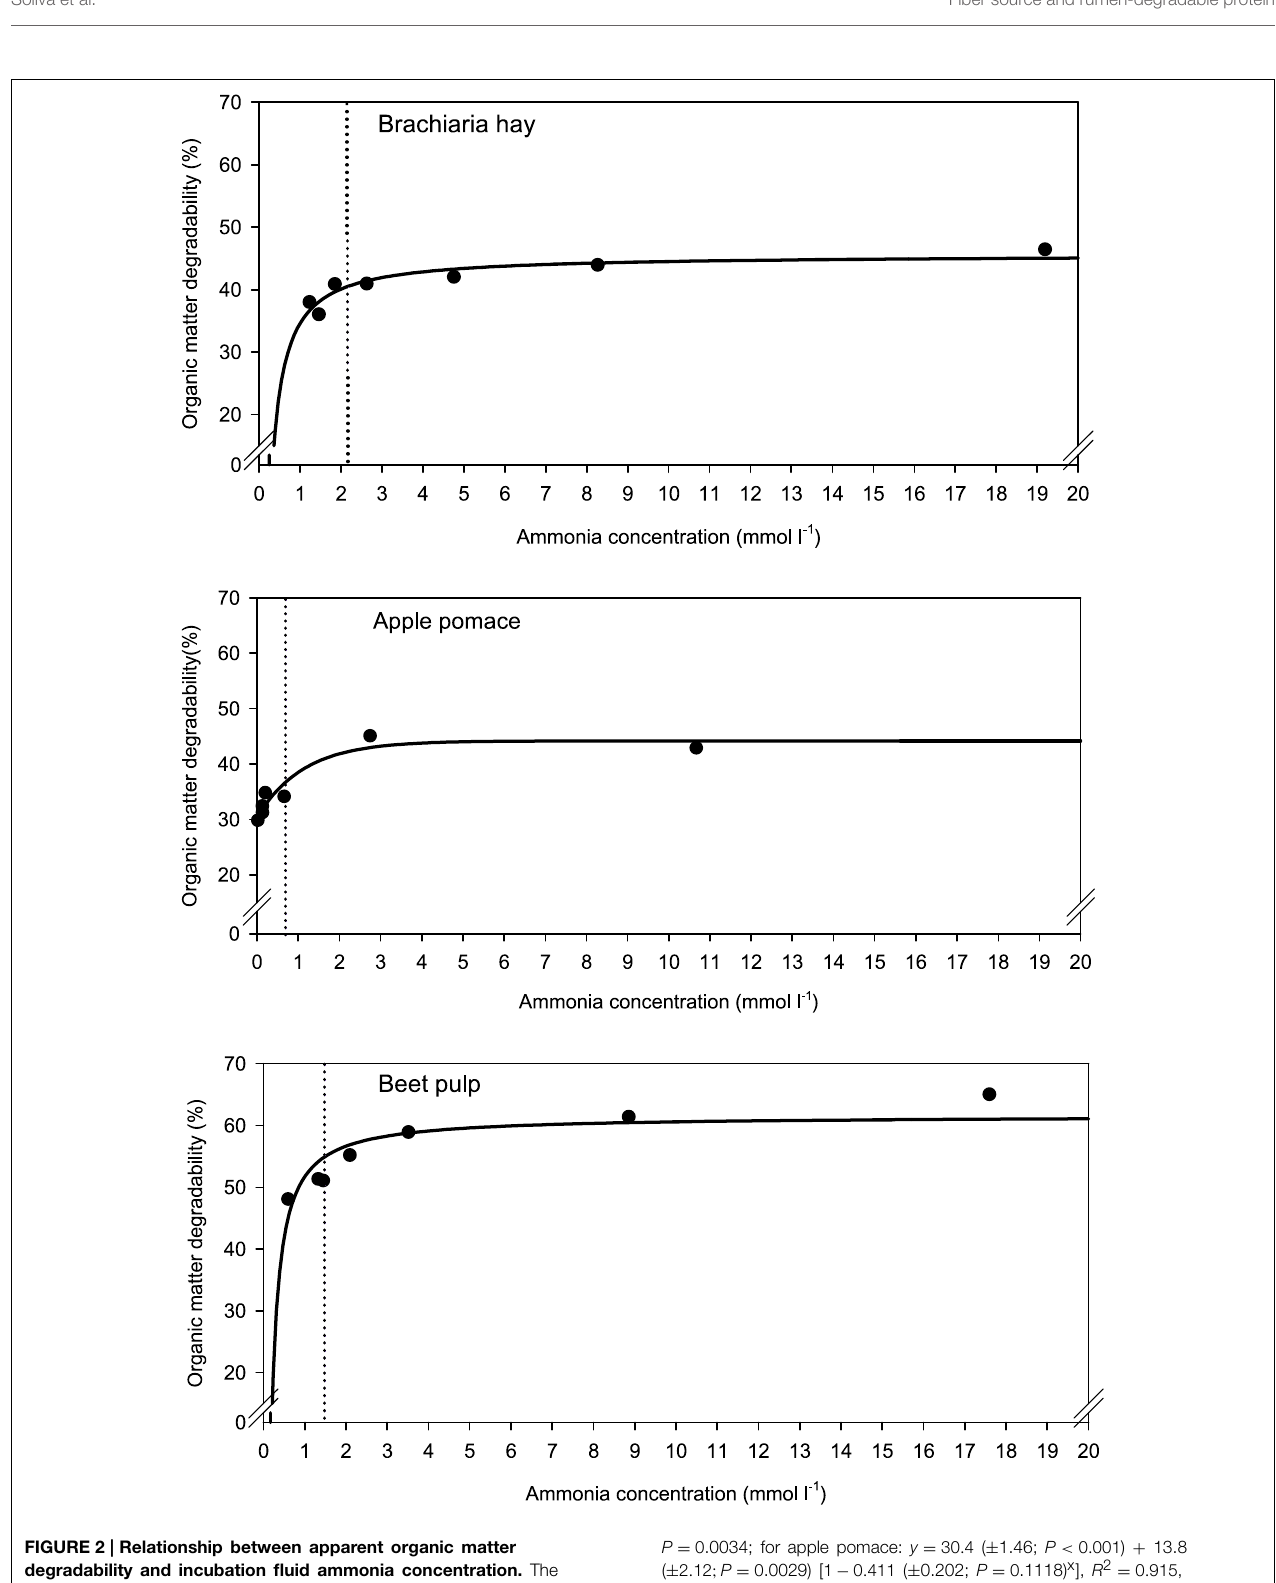
P = 0 .0034; for apple pomace: y = 30 . 4 ( ± 1.46; P < 0 . 001 ) + 13.8 ( ± 2 . 12 ; P = 0 .0029) [ 1 − 0 . 411 ( ± 0.202; P = 0 .1118) x ], R 2 = 0 . 915 , SE = 2 . 11 , P = 0 .0073; for beet pulp: y = 61 . 6 ( ± 1.82; P < 0 . 001 ) − 9.86 ( ± 2.35; P = 0 .0085) x − 1 , R 2 = 0 . 787 , SE = 3 . 18 , P < 0 . 001 . The significance of the difference of response across fiber sources was P = 0 . 159